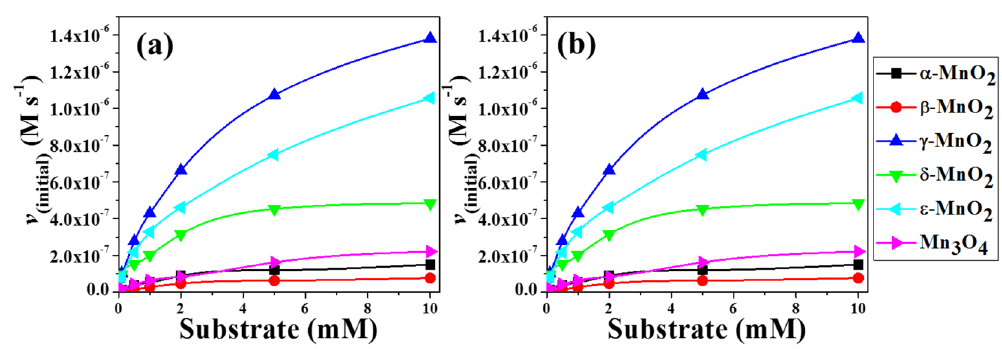
Figure 2. ( a ) The initial reaction rate of ABTS (0.01, 0.1, 0.5, 1, 2, 5, and 10 mM) by six MnO x nanomaterials (336 μ M) at pH 6.0, and ( b ) the double-reciprocal